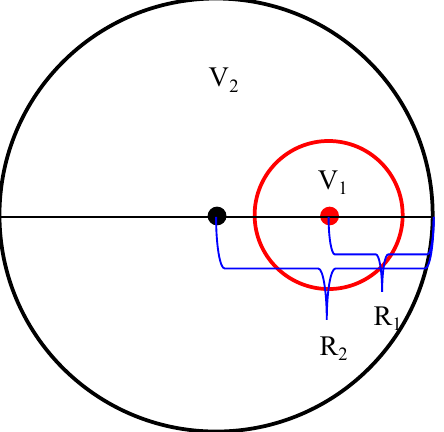
Figure 18. Schematic diagram of the oil cluster location distribution in the pore.